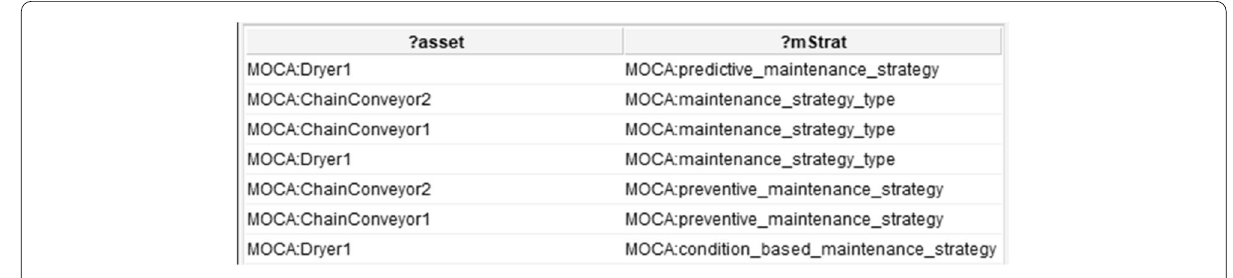
Figure 11 Maintenance strategy